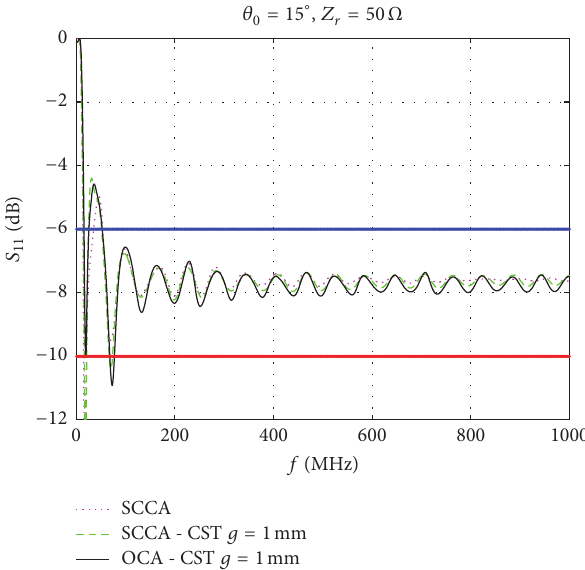
Figure 14: 𝑆 11 of the theoretical SCCA and the CST simulated SCCA and OCA for 𝜃 0 = 15 ∘ and 𝑍 𝑟 = 50 Ω .